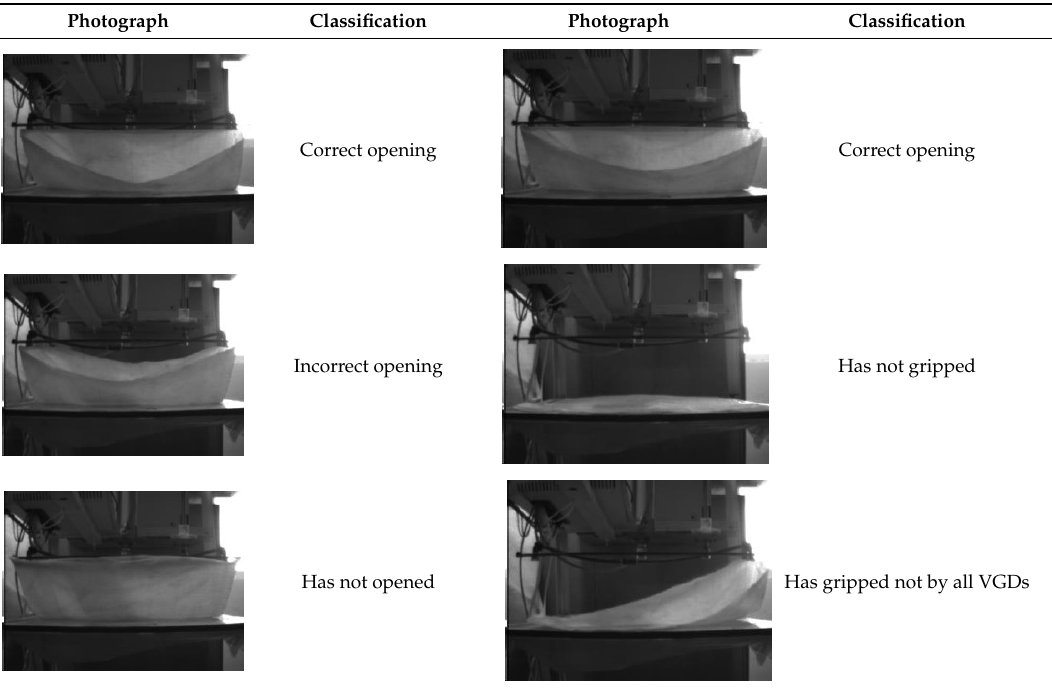
Table 1. Classification of photograph